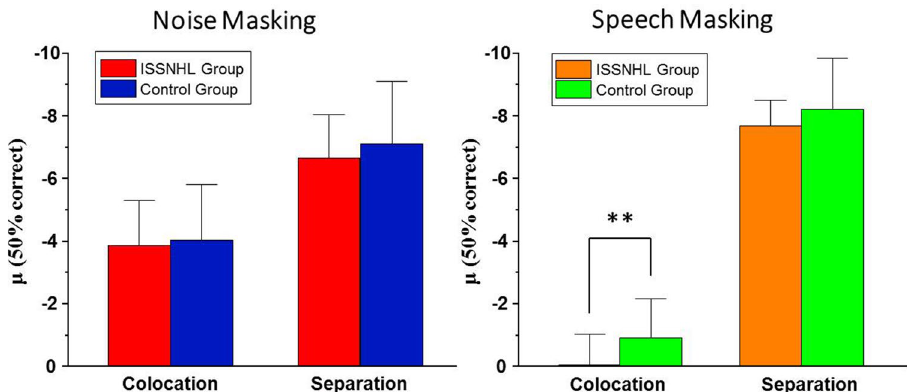
Figure 3. SIN perception threshold under each condition. The error bars represent the standard error of the mean (SEM).